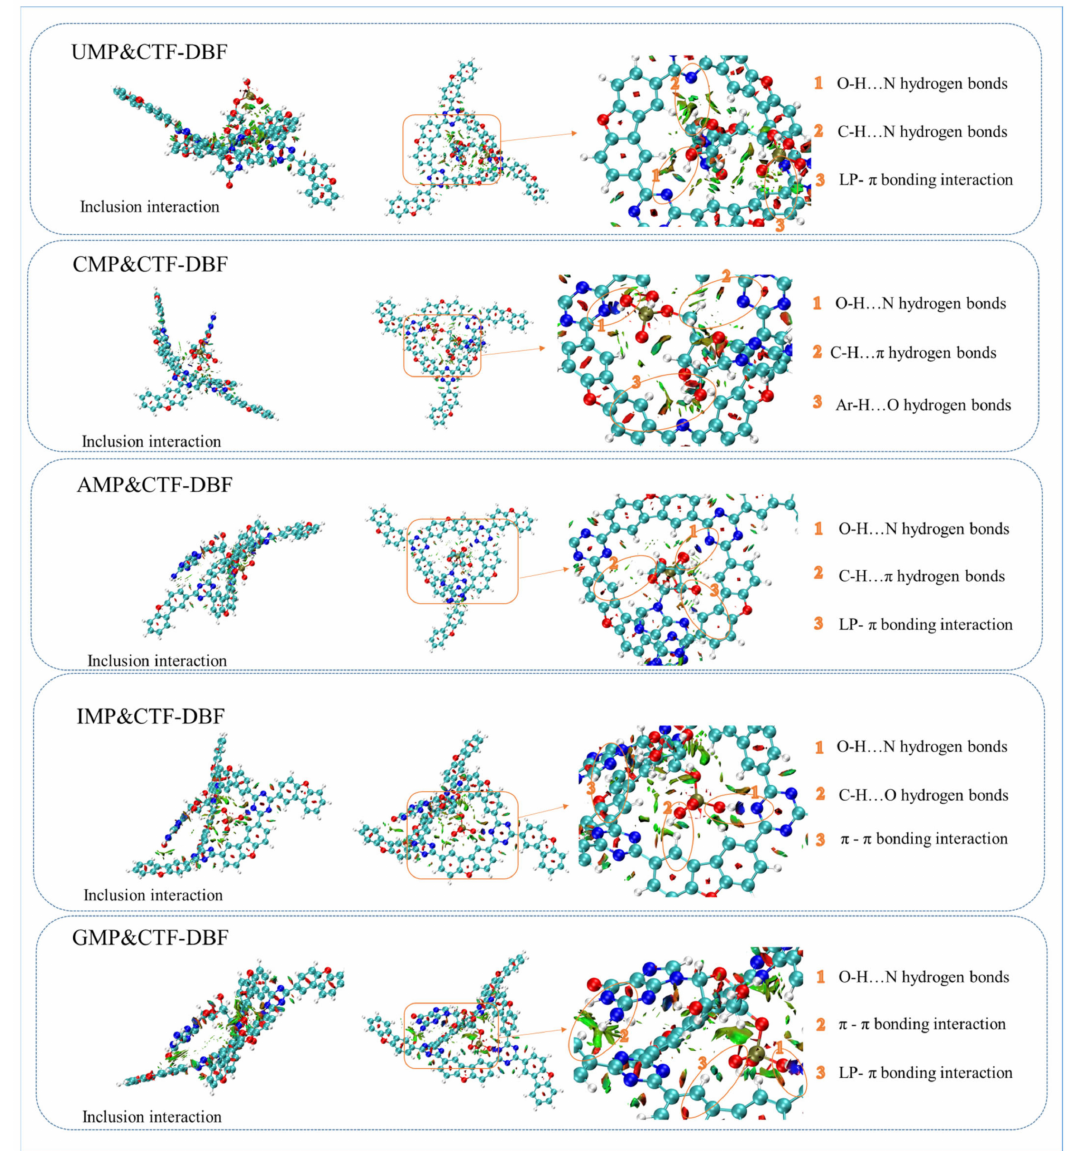
Figure 5. Theoretical analysis of non-covalent